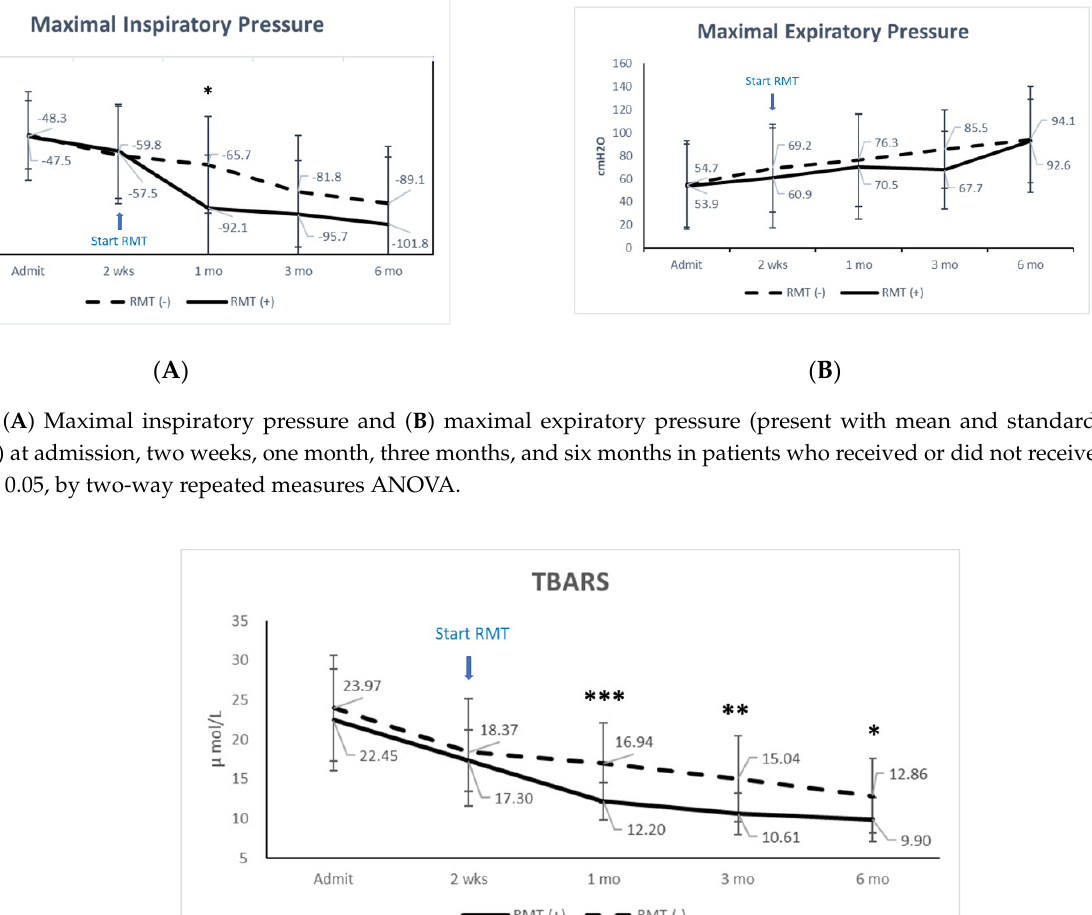
Figure 1. ( A ) Maximal inspiratory pressure and ( B ) maximal expiratory pressure (present with mean and standard deri- vation) at admission, two weeks, one month, three months, and six months in patients who received or did not receive RMT. * p < 0.05, by two-way repeated measures ANOVA.